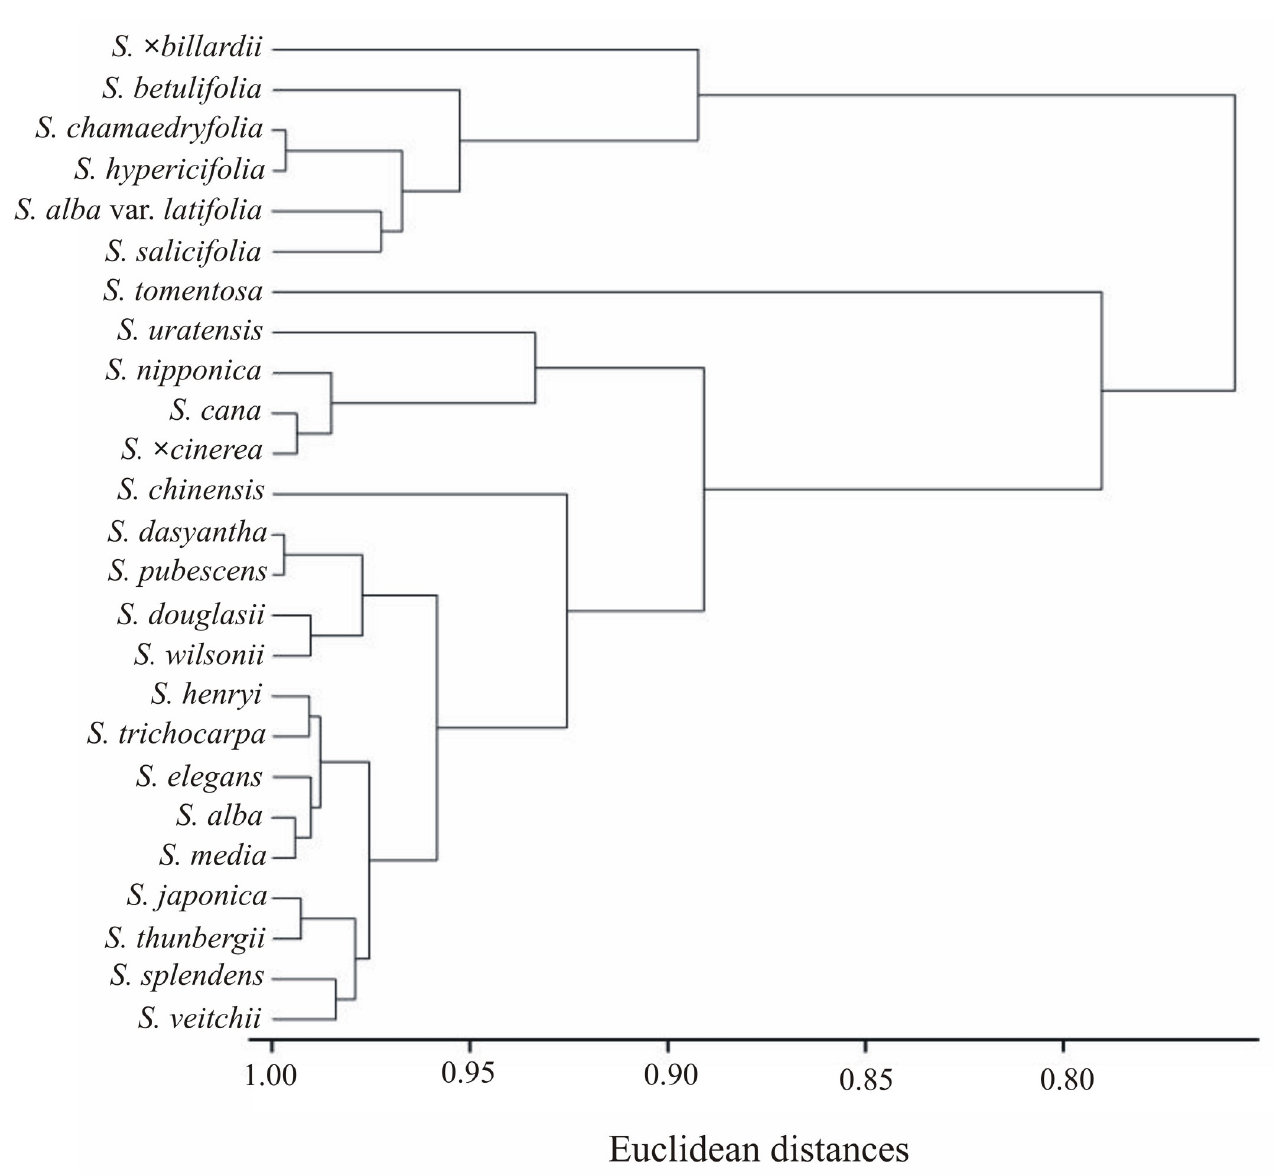
Fig 11. Clustering (Neighbor Joining Method) of Spiraea species based on all nine morphological traits.